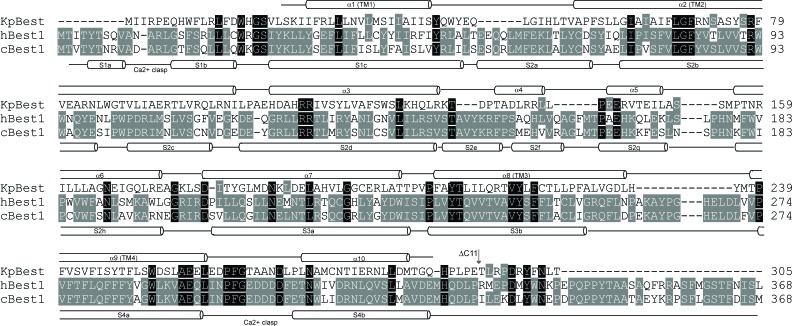
Structure-based sequence alignment of KpBest, hBest1 and cBest1.The KpBest structure has been used to restrict sequence gaps to inter-helical segments. Black background, identical residues in all three sequences; grey background, identical residues in two sequences. The secondary structures of KpBest and cBest1 are labeled above and underneath the sequences, respectively.